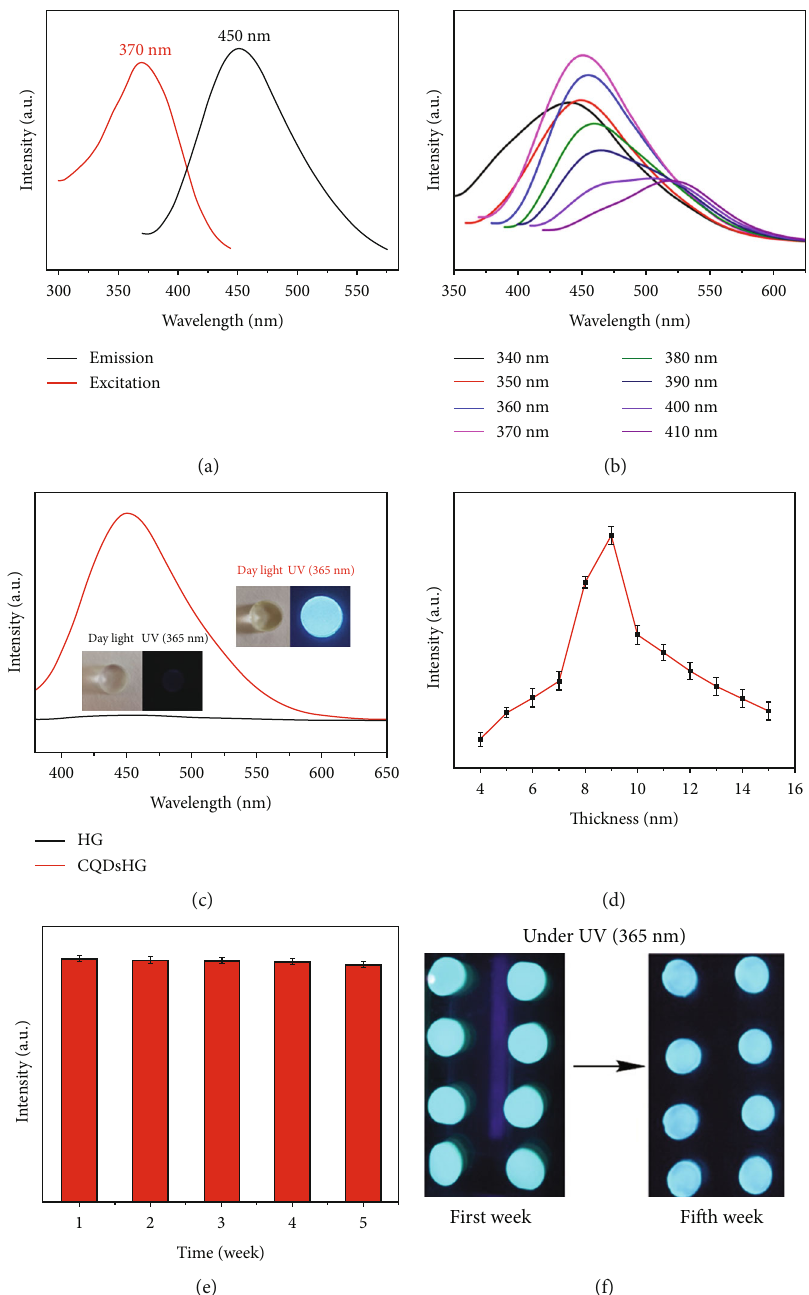
Figure 6: (a) Fluorescence spectra of the CQDsHG, (b) excitation wavelength-dependent fl uorescent emission spectra of the CQDsHG, (c) fl uorescent emission spectra of the CQDsHG and HG (insets are the photographs of CQDsHG and HG under day light and UV light), (d) in fl uence of CQDsHG thickness on fl uorescence intensity, (e) storage stability of the CQDsHG, and (f) photos of CQDsHG under UV light